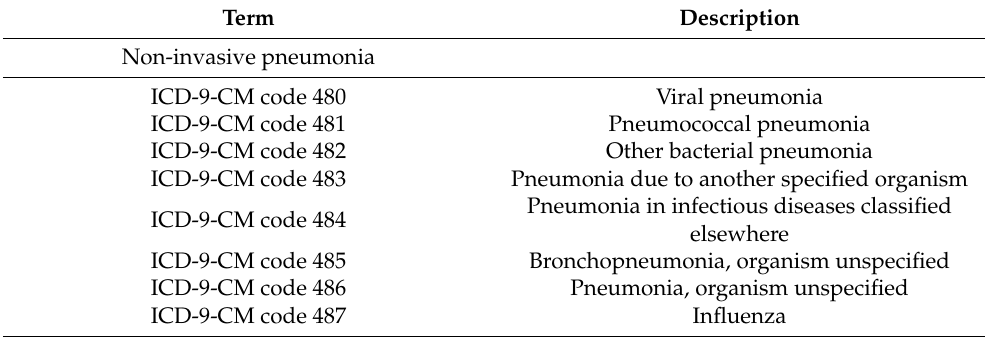
Table 1. Search terms and diagnoses of